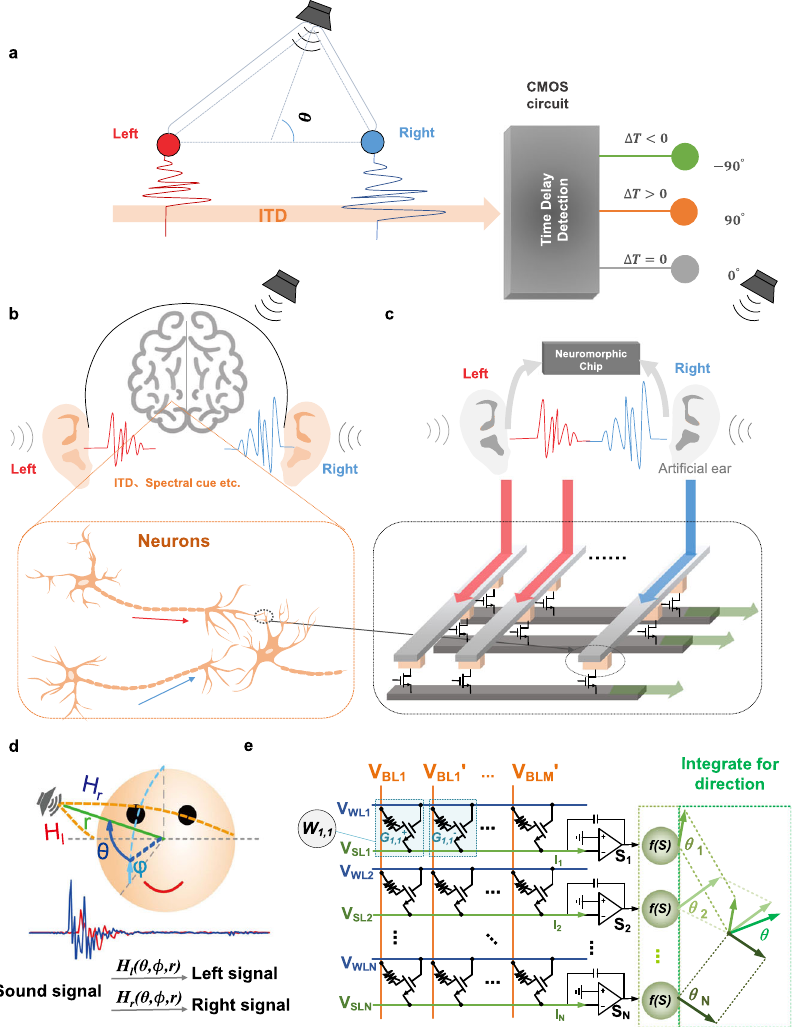
Fig. 1 The sound localization and hardware implementation. a The common implementation scheme for sound localization application with CMOS circuits: ITD theory. b Mechanism of sound localization in biological brain. Multiple binaural features are applied for neural processing to detect sound sources, including binaural time difference, spectral shape and so on. c A conceptual diagram of a memristor-based neuromorphic sound localization system. The memristor array acts as synapses to deal with binaural sound signals. d Sound source localization, HRTF and signal sample in the time domain. The transformation functions H l and H r are determined by the sound source azimuth angle θ , elevation ϕ , and distance r . e A schematic diagram for neural network implementation with an integrated memristor array. Since the weight in the neural network could either be a positive or negative value, it is mapped to two memristor cells as a differential